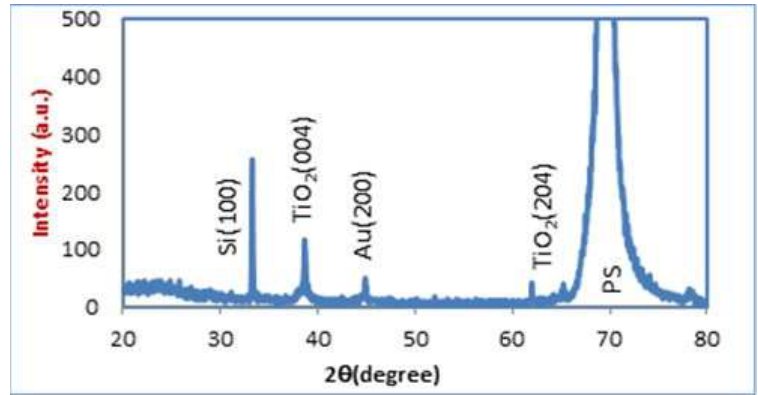
Figure 1: XRD pattern of Au:TiO 2 NPs/PS laser ablated at 800 mJ on PS preparing at etched current 12mA/cm 2 for 15 min. and HF c 16%.